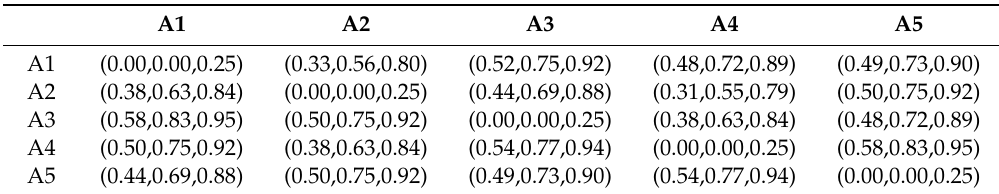
Table 5. The initial fuzzy direct-relation matrix ˜ Z